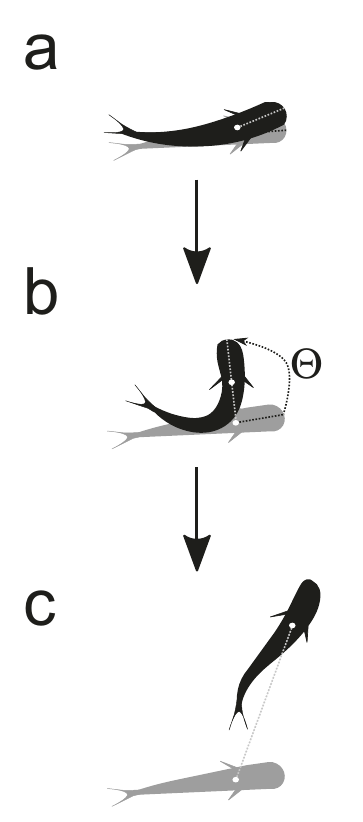
Fig. 1 Components of the fast-start escape response. This study examined the role of social familiarity in the reaction timing and kinematic performance of schools of the tropical damsel fi sh Chromis viridis , focusing on three key traits: latency, average turning rate, and distance covered. a Latency indicates the time period between the threatening stimulus breaking the water surface and the fi sh ’ s fi rst movement, with a shorter latency indicating a faster reaction time. b Average turning rate is measured by dividing the angle achieved during the fi rst unilateral bend of the reaction (i.e. stage 1) by the duration of time to achieve that angle, with a higher turning rate indicating greater agility in the response. c Distance covered indicates the distance moved during the fi rst 42 ms of the reaction, the mean time period for individuals to complete two body bends (i.e. stages 1 and 2), and is indicative of the response ’ s speed and acceleration. In all panels a – c , the grey fi sh silhouette indicates the fi sh ’ s position immediately prior to stimulation and the black fi sh indicates the fi sh ’ s position during each component of the fast-start escape